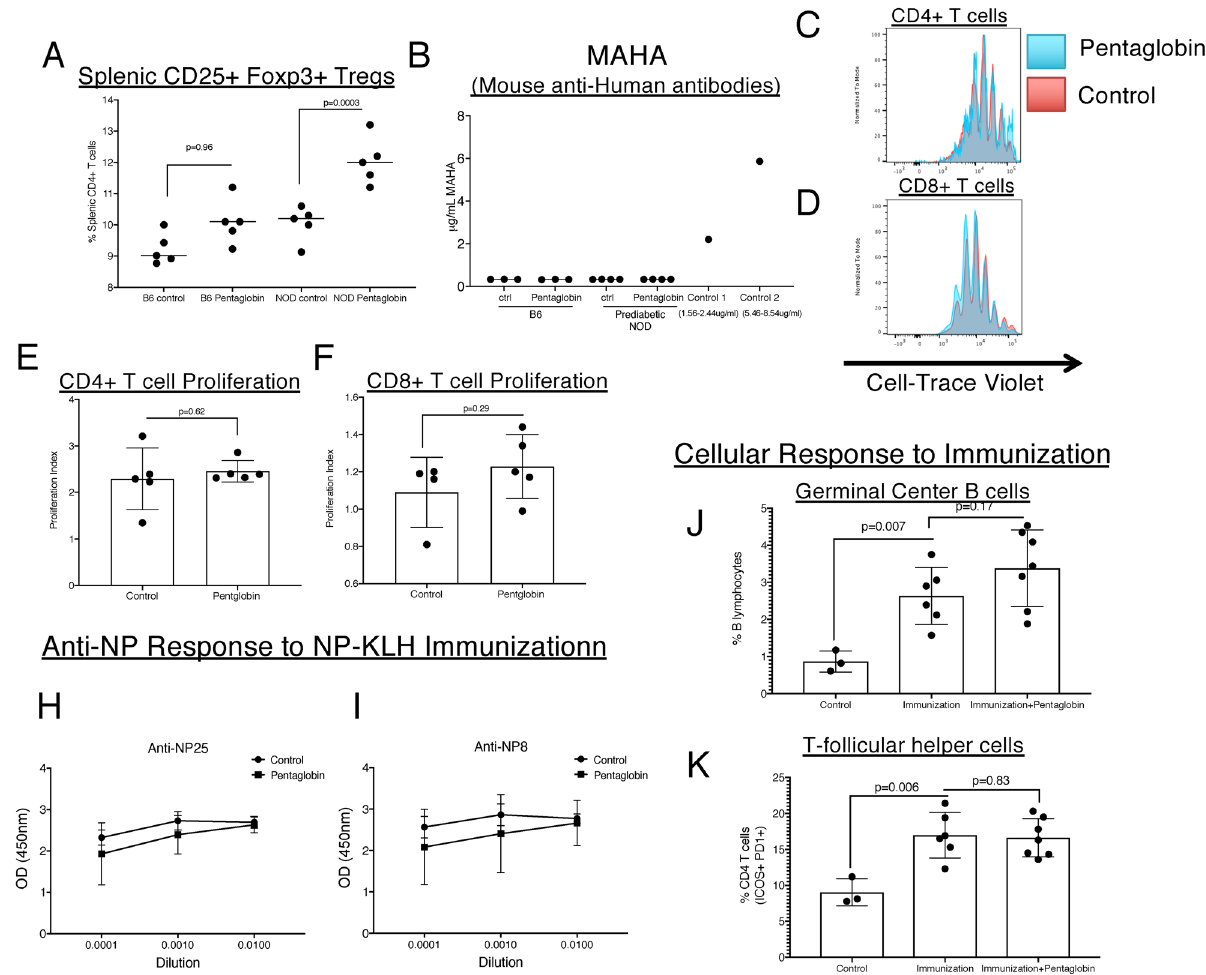
Figure 3. Pentaglobin fosters peripheral Treg expansion but does not induce robust immune suppression. ( A ) Analysis of the spleen revealed that Pentaglobin treatment expanded peripheral Tregs in NOD mice treated with Pentaglobin as was similarly evident in the thymus. ( B ) Although Pentaglobin did not appear to induce an immune response in treated mice, we measured the anti-human response in B6 and Prediabetic NOD mice. Using an ELISA that measures Mouse Anti-Human Antibodies (MAHA), minimal anti-human antibodies in B6 mice or NOD mice were detected before or after Pentaglobin treatment, as compared to assay controls. ( C ) To assess whether Pentaglobin was potently immunosuppressive, T cells from untreated control NOD mice and NOD mice treated with 2 doses of Pentaglobin were isolated. These cells were then labeled with a proliferation dye and cultured with anti-CD3 and anti-CD28. Proliferation of CD8 and CD4 T cells was scored by flow cytometry. No difference was observed in the proliferation of CD4 T cells. Proliferation index quantified in ( D ). ( E ) Likewise there was no difference in proliferation of CD8 T cells. Quantified in ( F ). ( H ), ( I ) To assess the B cell response, NOD mice were immunized with NP-KLH to measure T dependent B cell antibody production. Mice immunized with NP-KLH were treated with 2 doses of Pentaglobin or left untreated. Their anti-NP response was measured via ELISA. Low-affinity and high-affinity antibody responses (indicative of affinity maturation) were both intact. ( J ), ( K ) Flow analysis of the spleen from immunized mice demonstrated similar levels of GC B cells (B220 + IgM − Fas + GL7 +) and Tfh cells (CD4 + ICOS + PD − 1 to species-specific interactions. These interactions and their impact on immune function and disease demand further investigation in a clinical setting. Applying Pentaglobin therapy to humans with T1D will require moni- toring increases in Tregs, especially those newly emigrated from the thymus. The immune regulation of IgM has been linked to antigen specificity, structural changes, and glycosylation patterns 18,19,21–25 . It is possible that the human IgM bound with less affinity to immune cell subsets, due to epitope differences in cell surface molecules. While we provided the same total amount of IgM as previous studies, the amount of effective, therapeutic IgM may have differed due to the different isolation techniques. Additionally, the amount of IgG delivered concomitantly with IgM may have counteracted or masked immune changes induced by IgM alone. The higher dosage, while containing more IgM, was less effective at diabetes reversal, suggesting interactions with other components of Pentaglobin.